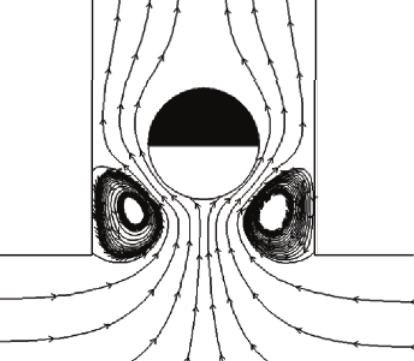
Figure 4: The flow diagram around the Janus cylinder when 𝐸 = 2𝑒5 V / m.